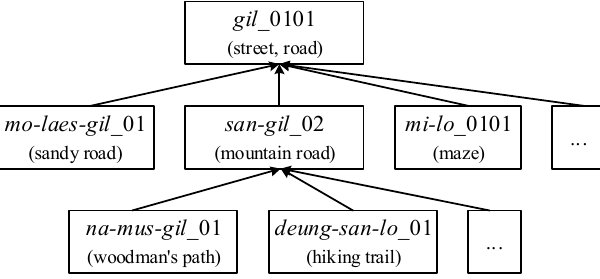
Figure 3. Hypernyms of “ gil_ 0101” in the Korean lexical-semantic network—UWordMap.